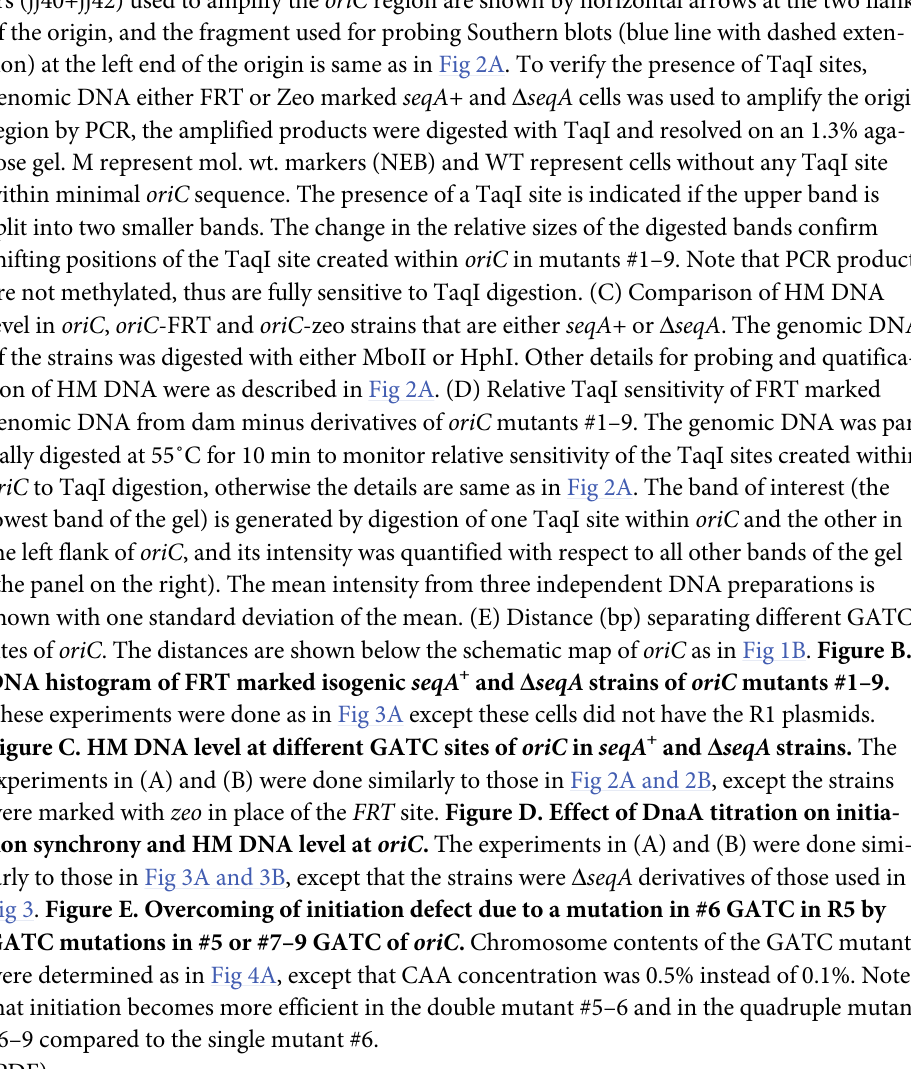
These experiments were done as in Fig 3A except these cells did not have the R1 plasmids. Figure C. HM DNA level at different GATC sites of oriC in seqA + and Δ seqA strains. The experiments in (A) and (B) were done similarly to those in Fig 2A and 2B, except the strains were marked with zeo in place of the FRT site. Figure D. Effect of DnaA titration on initia- tion synchrony and HM DNA level at oriC . The experiments in (A) and (B) were done simi- larly to those in Fig 3A and 3B, except that the strains were Δ seqA derivatives of those used in Fig 3. Figure E. Overcoming of initiation defect due to a mutation in #6 GATC in R5 by GATC mutations in #5 or #7–9 GATC of oriC . Chromosome contents of the GATC mutants were determined as in Fig 4A, except that CAA concentration was 0.5% instead of 0.1%. Note that initiation becomes more efficient in the double mutant #5–6 and in the quadruple mutant #6–9 compared to the single mutant